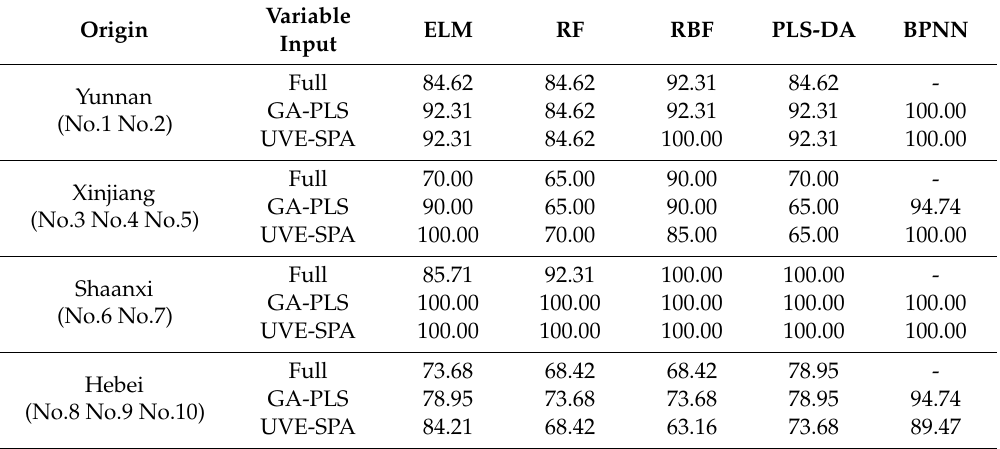
Table 2. Modeling performances to classify varieties within the same origin on a test set built from the full spectral range and subsets of the selected variable using di ff erent classifiers.